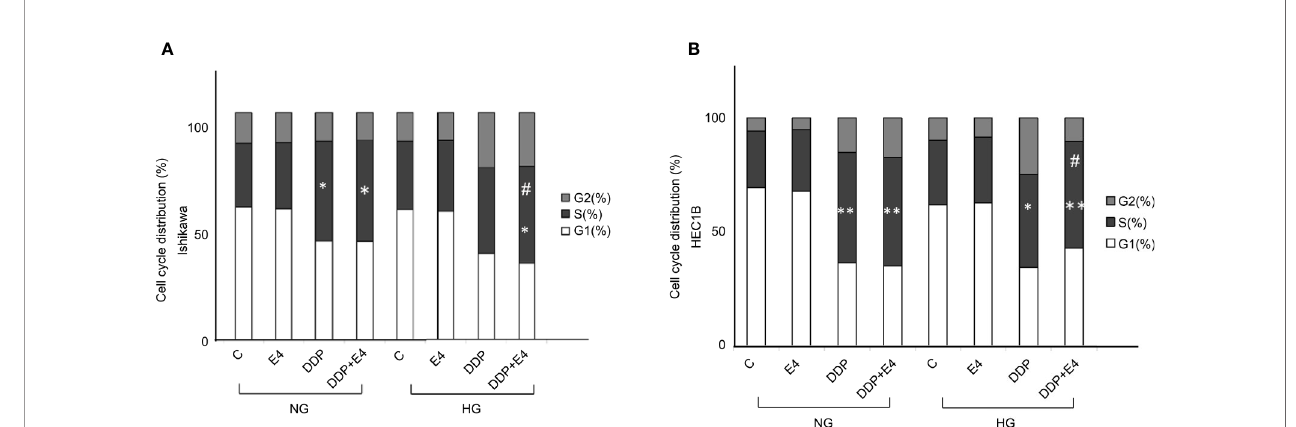
FIGURE 4 | Effects of Exe-4 and DDP under high glucose (HG) on cell cycle in Ishikawa and HEC1B cells. Cells were cultured for 8 weeks under NG and HG conditions, incubated for 48 h with Exe-4 (10 nM), DDP (25 µM), and DDP (25 µM) + Exe-4 (10 nM), respectively, and analyzed for DNA content by FACS analysis. The panels represent the distribution of cells in different phases of the cell cycle. Measurements (n = 3) were performed. ∗ p < 0.05 DDP (25 µM), DDP (25 µM) + Exe- 4 (10 nM) vs . control group and Exe-4 (10 nM) in Ishikawa cells cultured in NG; ∗ p < 0.05 DDP (25µM) + Exe-4 (10 nM) vs . Exe-4 (10 nM) in Ishikawa cells cultured in HG; # p < 0.05 DDP (25µM) + Exe-4 (10 nM) vs . DDP (25 µM) in Ishikawa cells cultured in HG (A) . ∗ p < 0.01 DDP (25 µM), DDP (25 µM) + Exe-4 (10 nM) vs . control group and Exe-4 (10 nM) in HEC1B cells cultured in NG; ∗ p < 0.05 DDP (25 µM), **p < 0.01 DDP (25 µM) + Exe-4 (10 nM) vs . control group and Exe-4 (10 nM) in HEC1B cells cultured in HG; # p < 0.05 DDP (25µM) + Exe-4 (10 nM) vs . DDP (25µM) in HEC1B cells cultured in HG (B)